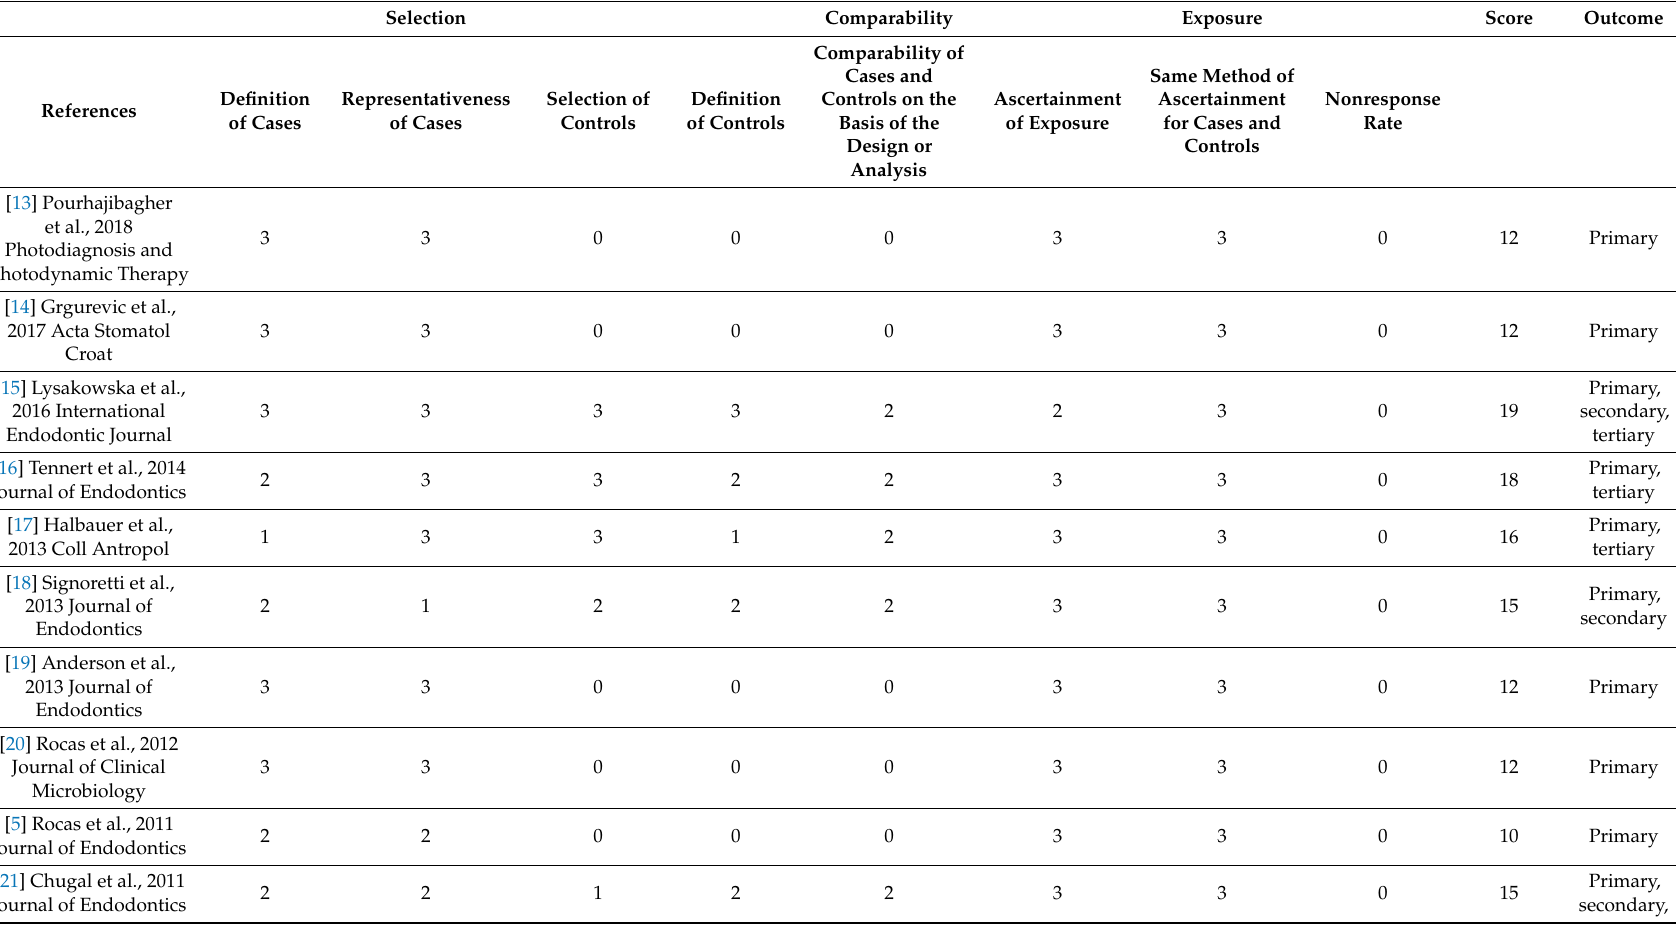
Table 6. Assessment of risk of bias within the studies (Newcastle–Ottawa scale) with scores 7 to 12 = low quality, 13 to 20 = intermediate quality, and 21 to 24 = high